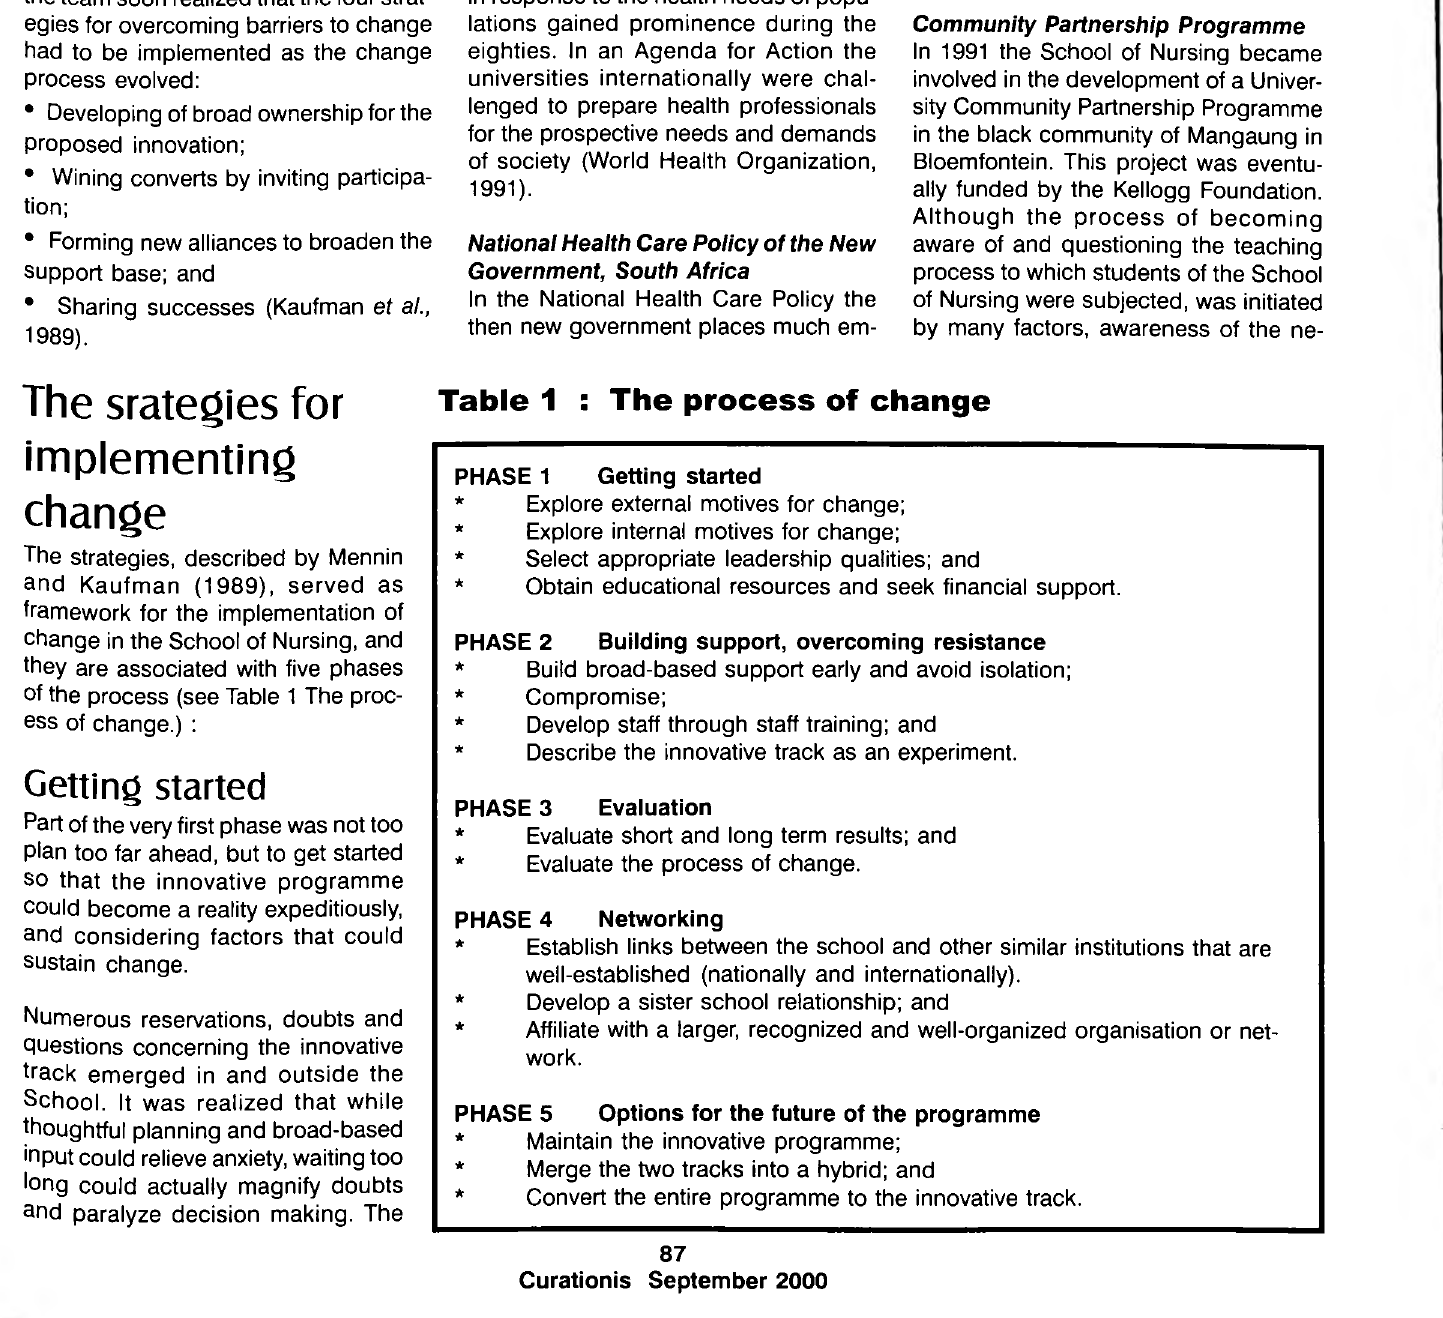
Table 1 : T h e process of